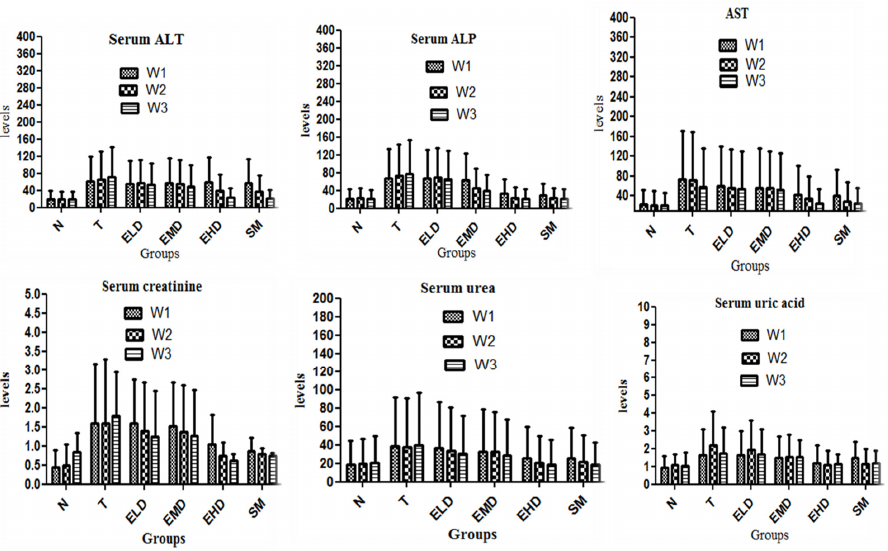
Figure 3. Graphical representation of liver related and other serum parameters at week 1, week 2 and week 3 of different experimental groups (Table 3).